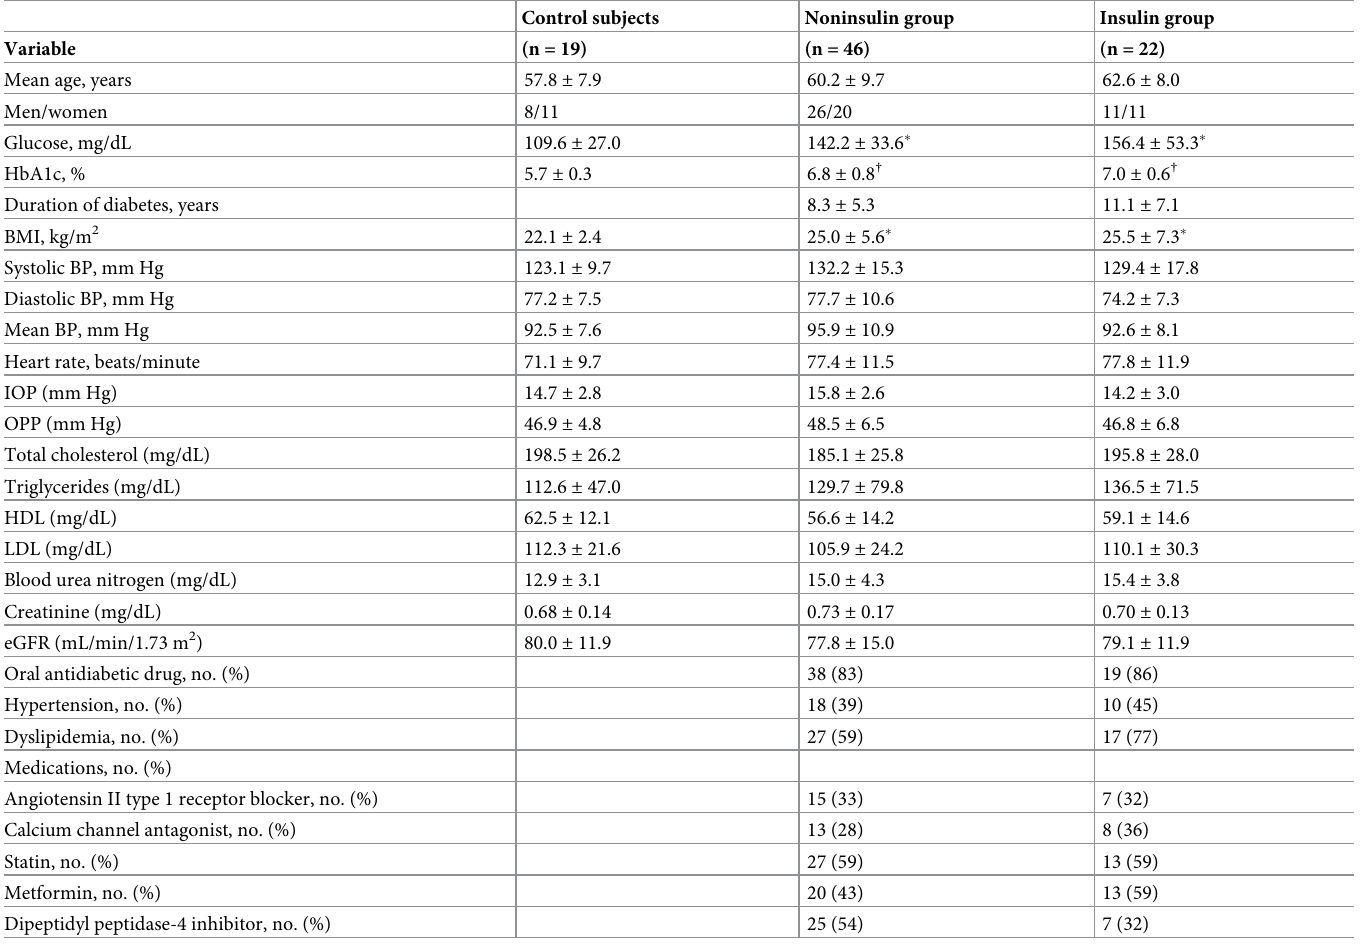
Table 3. Characteristics of control subjects and patients with or without insulin